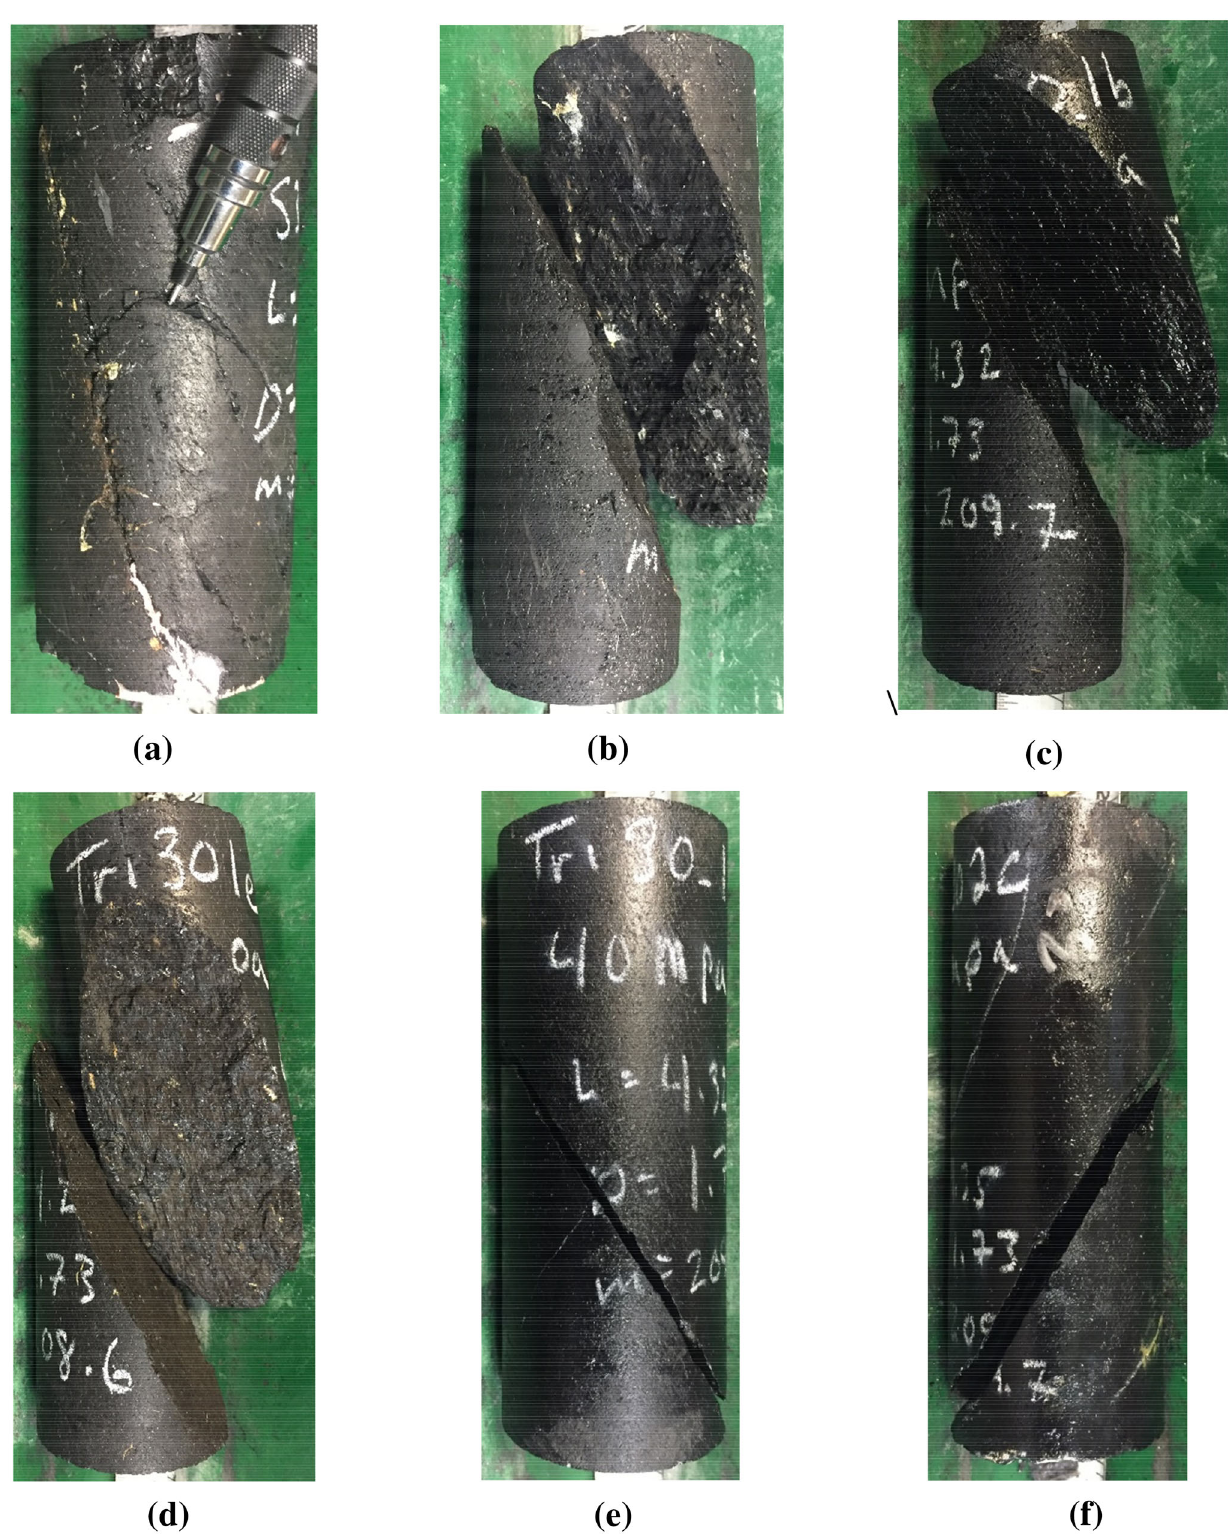
Fig. 3 Examples of failed coal specimens with 30 (cid:3) included angle (mean UCS 16 MPa) after triaxial compressive strength testing: a confining stress of 4 MPa; b confining stress of 8 MPa; c confining stress of 16 MPa; d confining stress of 32 MPa; e confining stress of 40 MPa; f confining stress of 64